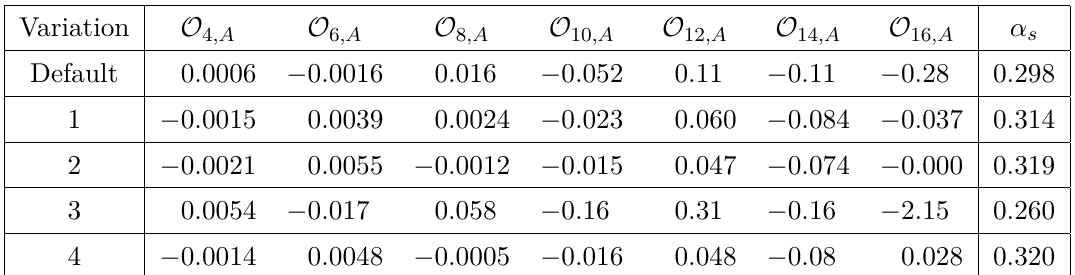
Table 9 . Fitted values of the OPE axial condensates, in GeV units, obtained with the different modifications of the ansatz and